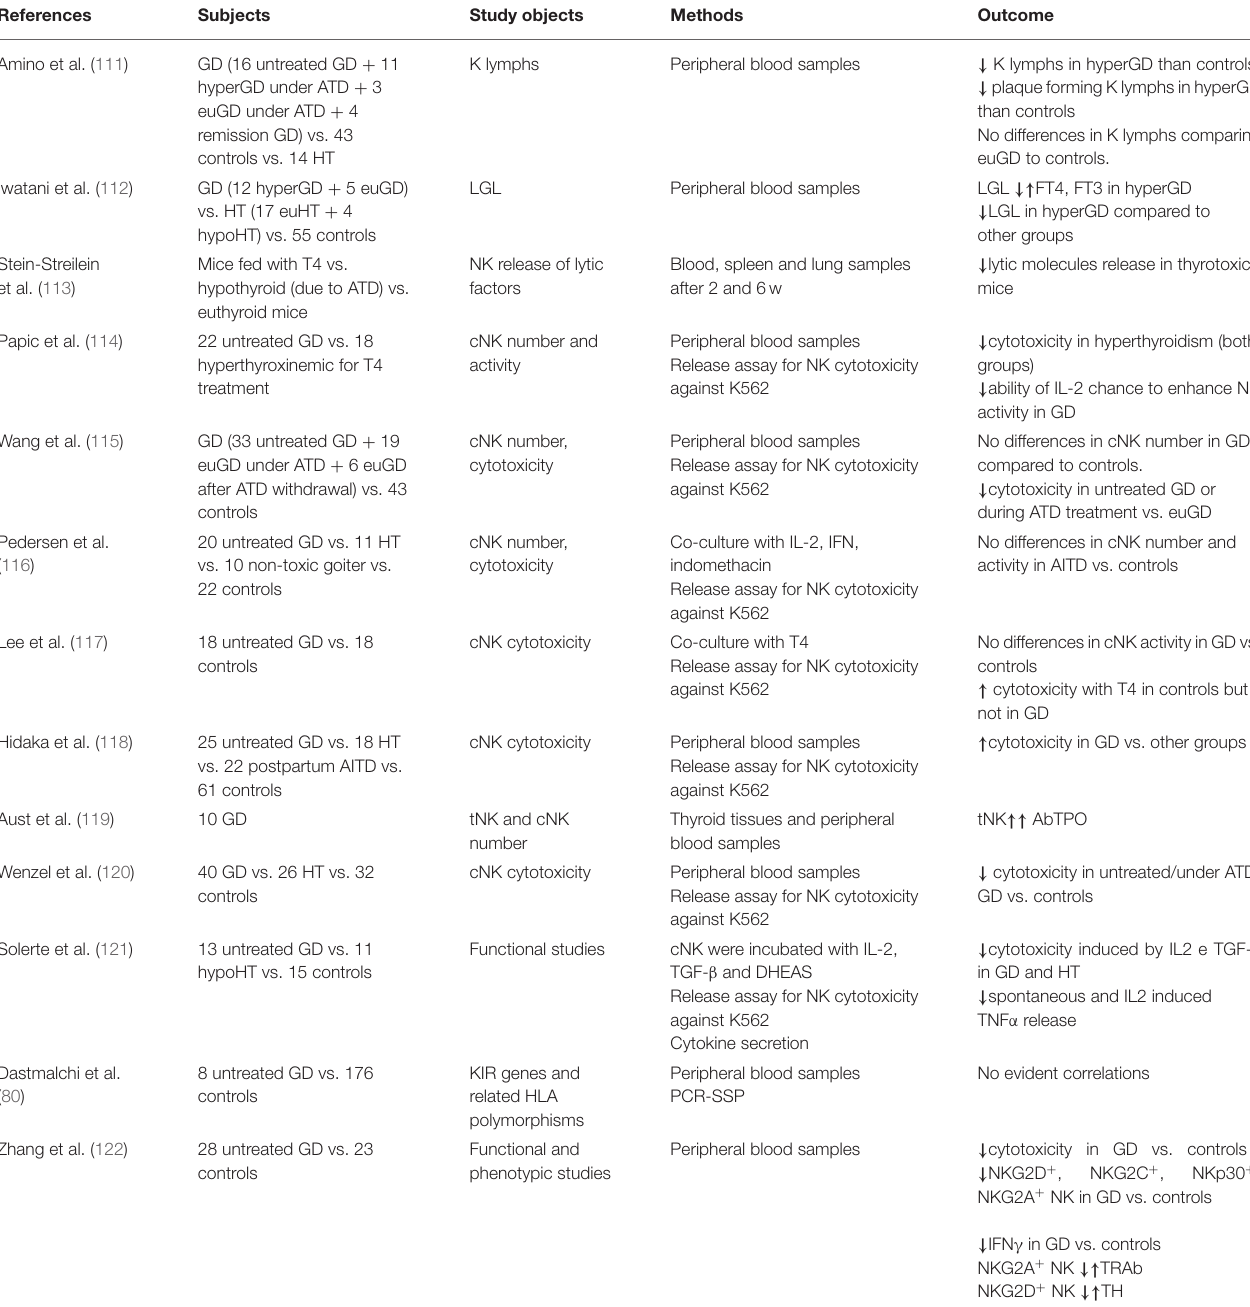
TABLE 1 | Summary of studies investigating the role of natural killer cells in Graves’ disease.